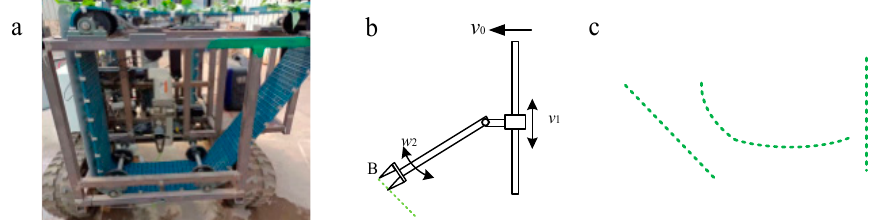
Figure 13. Robot arm-type sweet potato transplantation. ( a ) Transplanter; ( b ) transplanting principle; ( c ) transplanting trajectory.